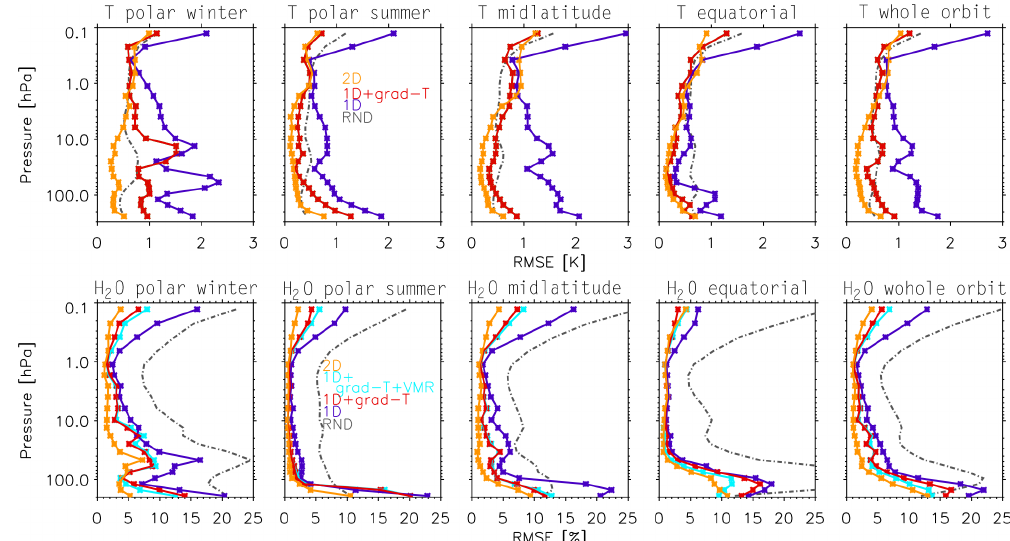
Figure 5. RMSE (root mean square error) calculations for temperature (upper panels) and H 2 O (lower panels) in polar winter, polar summer, midlatitude, equatorial and whole orbit scenarios. Blue for 1-D, red for 1-D + grad( T ), cyan for 1-D + grad( T ,VMR) and orange for 2-D. Grey line represents the average ORM random error